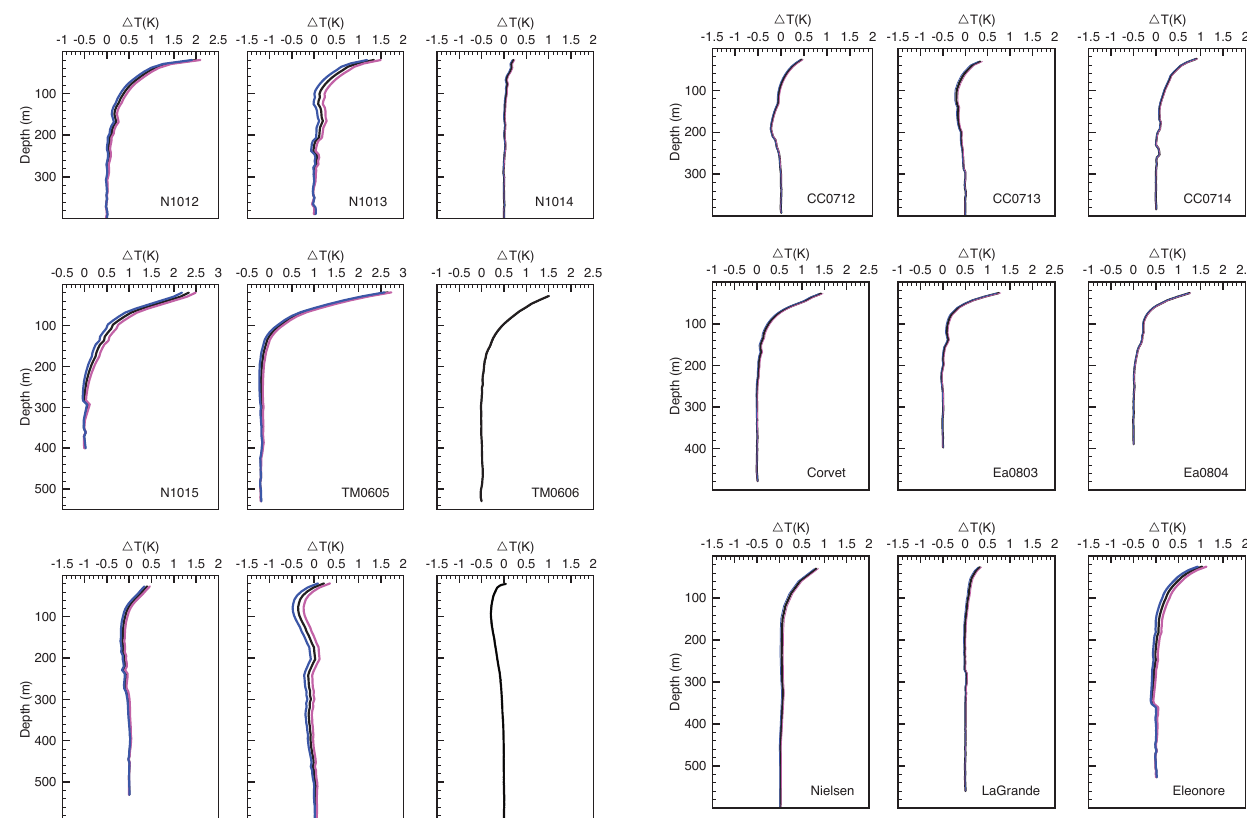
Figure 3. Temperature anomalies for the northern Québec bore- holes. CC0712, CC0713, and CC0714 are the boreholes from Camp Coulon; Ea0803 and Ea0804 are the boreholes from Eastmain. The anomaly is obtained by subtracting the estimated steady-state geotherm obtained by the least-square fit of a straight line to the bottom 100m of the borehole temperature–depth profile. The black line represents the best linear fit, while the pink and blue lines repre- sent the upper and lower bounds, respectively, of the 2 σ confidence intervals. For N1014, TM0606, and Otoskwin, the upper and lower bounds of the confidence interval are not visible due to the temper- ature scale. The temperature anomaly at Nielsen Island was cut at